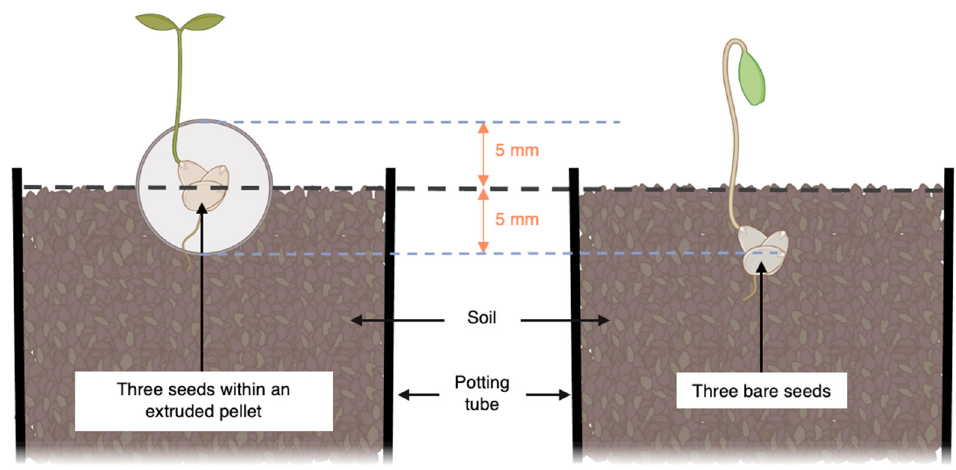
Figure 1. Frontal plane diagram of the upper portion of nursery tubes (6 cm wide sides, 20 cm deep) depicting the depth from the soil surface at which seeds were placed when encapsulated in pellets (left; as per seed treatments ‘Standard Pellet’, ‘Vermicast Extract Pellet’, and ‘Native Soil Pellet’) and when kept bare (right; as per seed treatment ‘No Pellet’). Note that the relative sowing depths of the bare and the pelleted seeds are equal (c. 5 mm). Figure created using elements from BioRender.com (accessed on 15 September 2022).